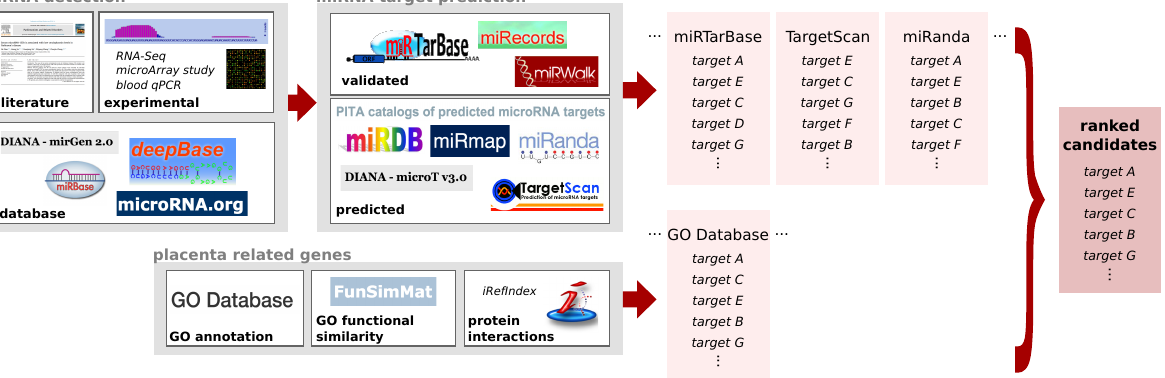
Figure 2. Computational approach to detect microRNAs as potential biomarkers. miRNAs of interest can be detected experimentally and found in the literature or databases. Alternatively miRNAs can be predicted in silico and verified by transcription expression profiles. miRNA target prediction can be performed with various tools, each ranking the possible target by a score, p-value, and other criteria. Placenta-related protein genes can be obtained from databases for annotation, function or protein–protein interaction or other sources, such as own experimental data. Combining all information results in a comprehensive candidate list for miRNA and possible target